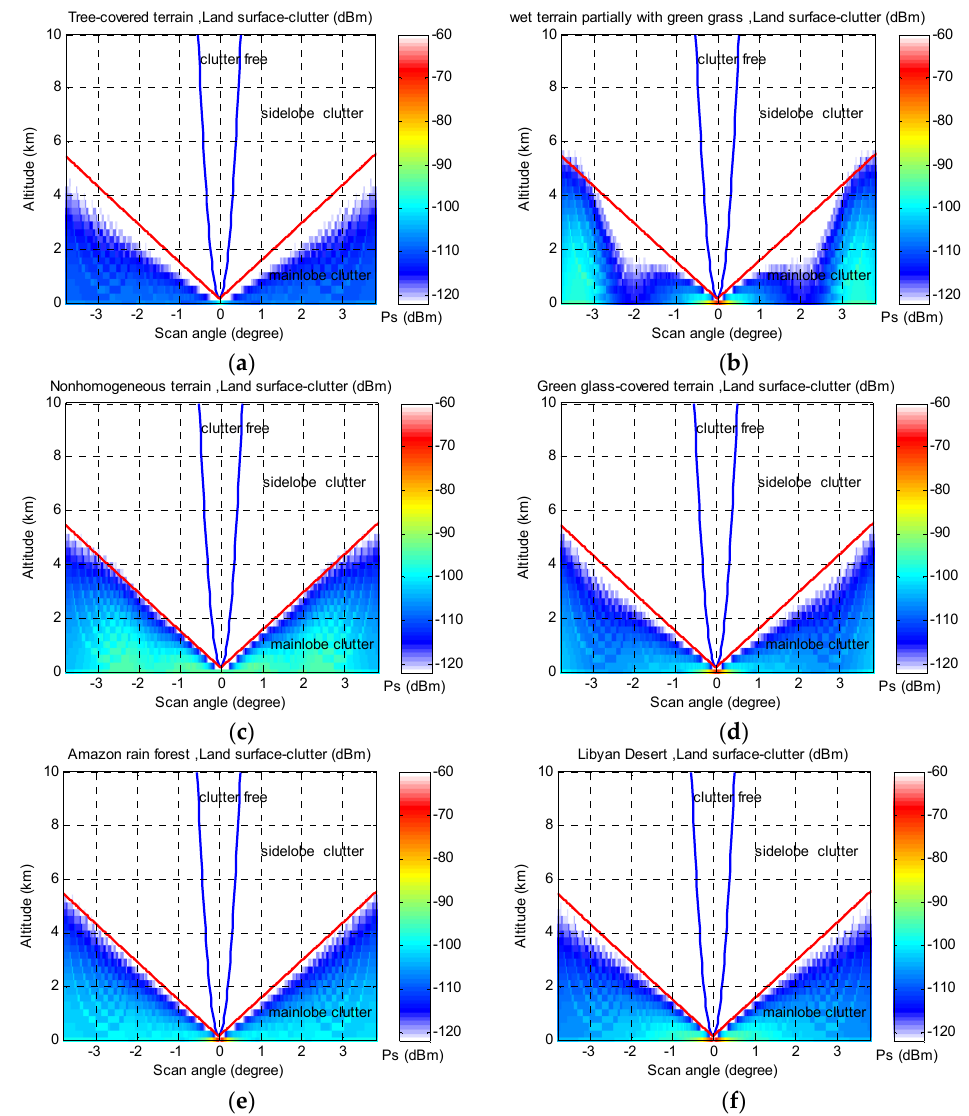
Figure 5. Power distribution (dBm) of land surface clutter at different spiral scan angle, without rain attenuation. ( a ) The terrain of Amazon rain forest; ( b ) terrain covered with wet terrain, partially with green grass; ( c ) a nonhomogeneous terrain, such as sand, marsh, and bushes; ( d ) a terrain covered with tall green weeds; ( e ) the terrain of the Amazon rainforest; and ( f ) the terrain of Libyan desert.